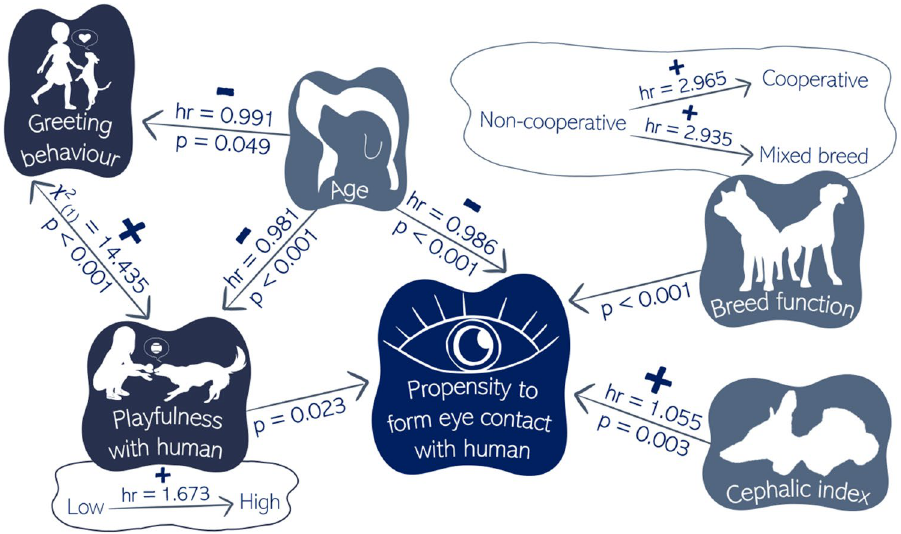
Figure 8. Summary diagram of the main results (created by using drawings designed by Freepik 51 ). Each effects’ hazard ratios (hr) and p values ( p ) are presented. The levels of categorical variables are presented separately, and the direction of the effects are shown (“ + ” positive and “ − ”